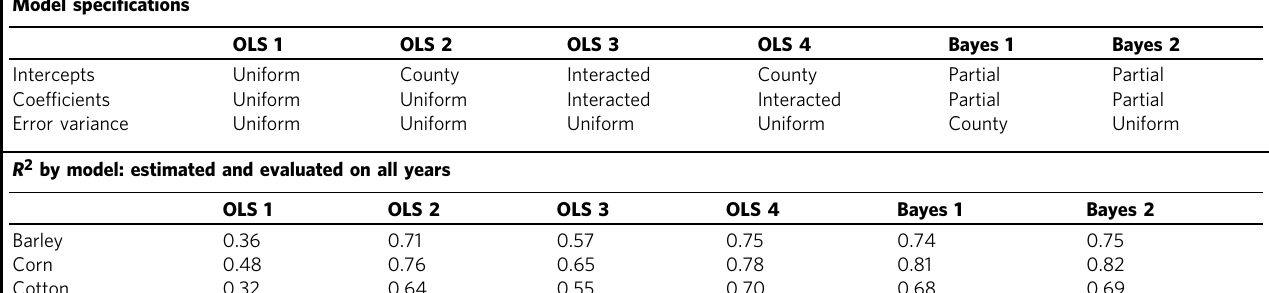
Table 1 Comparison of the predictive power of OLS and Bayesian yield models.